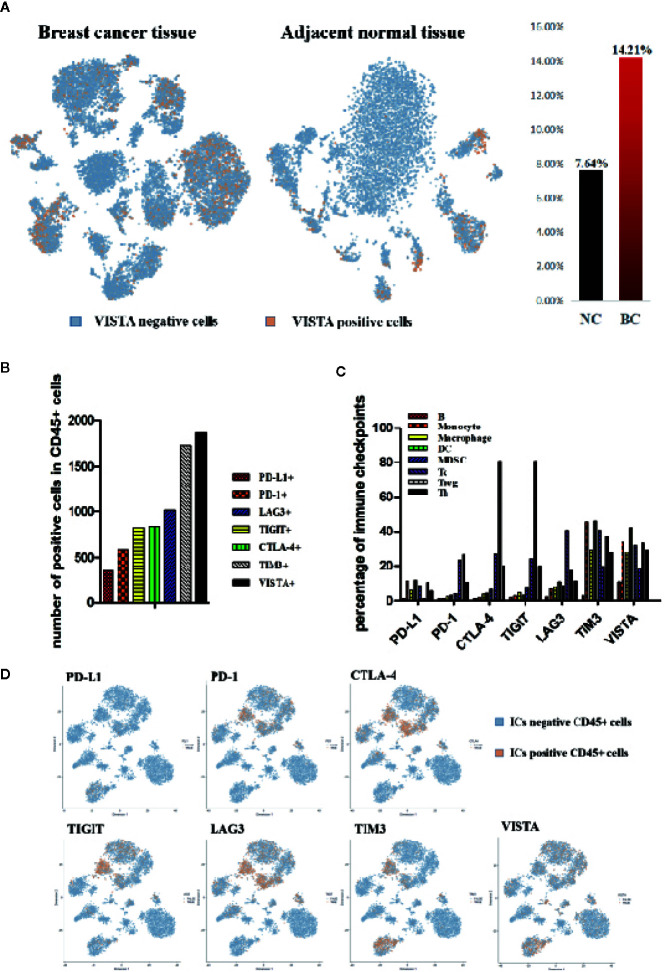
Immune Checkpoints expressions heterogeneity in immune cell populations in the breast cancer tissue. (A) t-SNE of normalized single-cell RNA-seq data for VISTA colored by markers. VISTA positive cells (orange), VISTA negative (blue). (B) Histogram of the expression of each immune checkpoint (PD-L1, PD-1, CTLA-4, TIGIT, LAG3, TIM3 and VISTA) in the microenvironment of breast cancer tissue. (C) Histogram of percentage of each immune checkpoint (PD-L1, PD-1, CTLA-4, TIGIT, LAG3, TIM3 and VISTA) in the primary immune cell subpopulation in the breast cancer microenvironment. (D) t-SNE of normalized single-cell RNA-seq data for ICs (immune checkpoints) colored by markers. ICs positive cells (orange), ICs negative (blue).